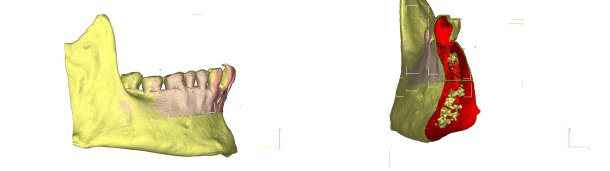
Figure 8. Combined higher resolution CBCT scans: general view (a) and transverse section